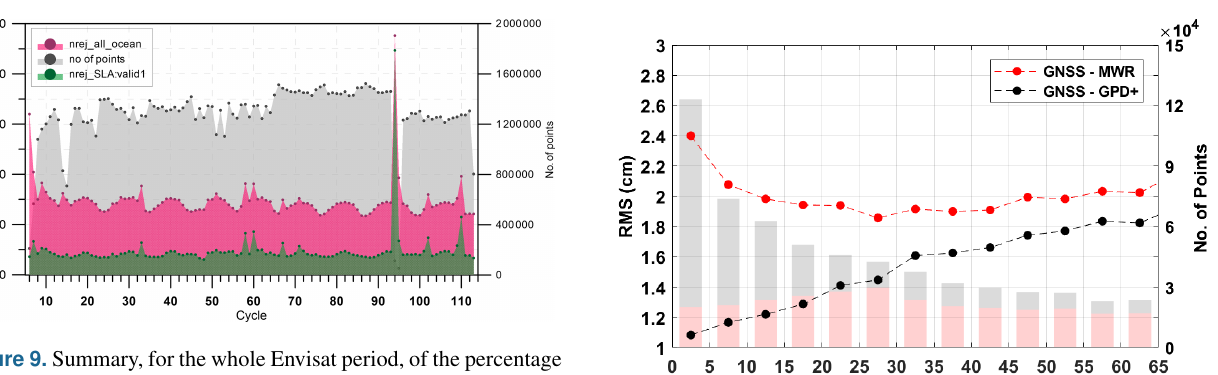
Figure 9. Summary, for the whole Envisat period, of the percentage of points with a rejected MWR-derived WTC, for which a GPD + estimate has been computed (pink), and for which a valid SLA value could be computed after the estimation of the WTC by GPD + (green). Also shown in grey is the number of points with valid SLA values per cycle.